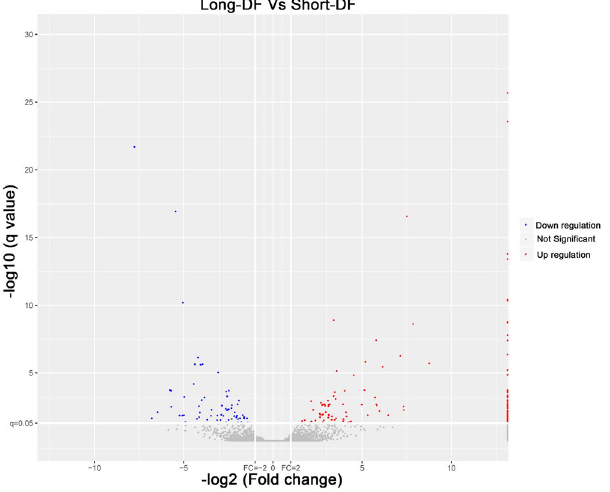
Figure 5. The differentially expressed (DE) lncRNAs between the long- and short-DF hens. The red and blue dots represent up- and down-regulated lncRNAs respectively. The grey dots represent the lncRNAs without significant differential expression.